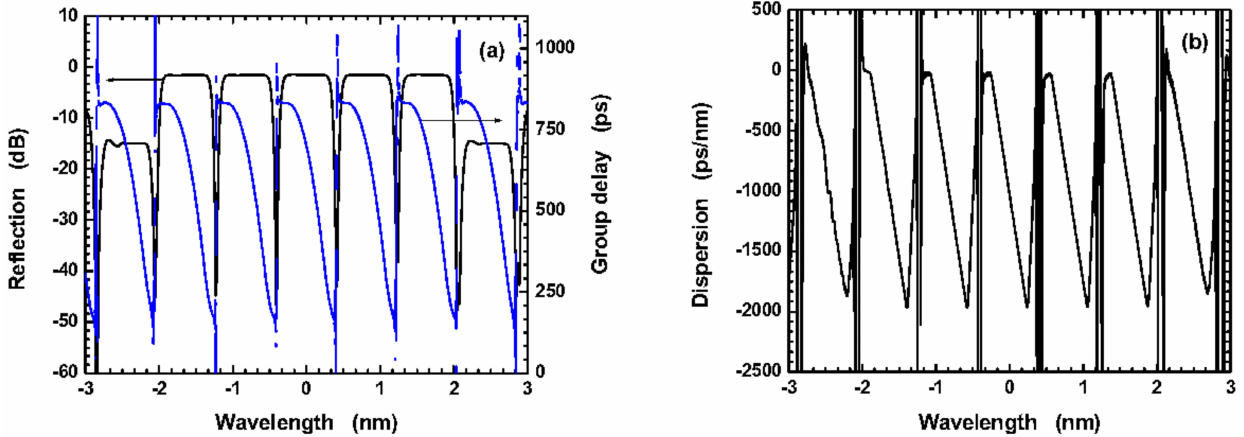
Figure 22. Measurement results of five-channel nonlinearly chirped FBG. ( a ) Reflection and group- delay spectrum. ( b ) Dispersion spectrum. Adapted with permission from ref. [107]. © [2022] IEEE.